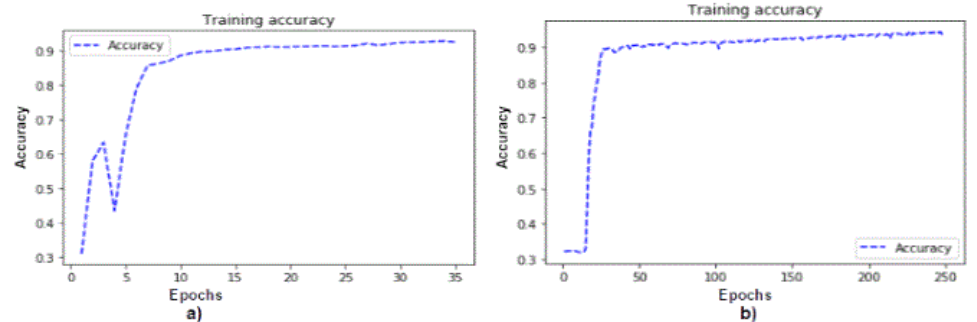
Figure 6. The training accuracy results curves of the proposed system on the ISBI 2017 and PH2 datasets. ( a ) Accuracy results curve on ISBI 2017 dataset; ( b ) Accuracy results curve on PH2 dataset.